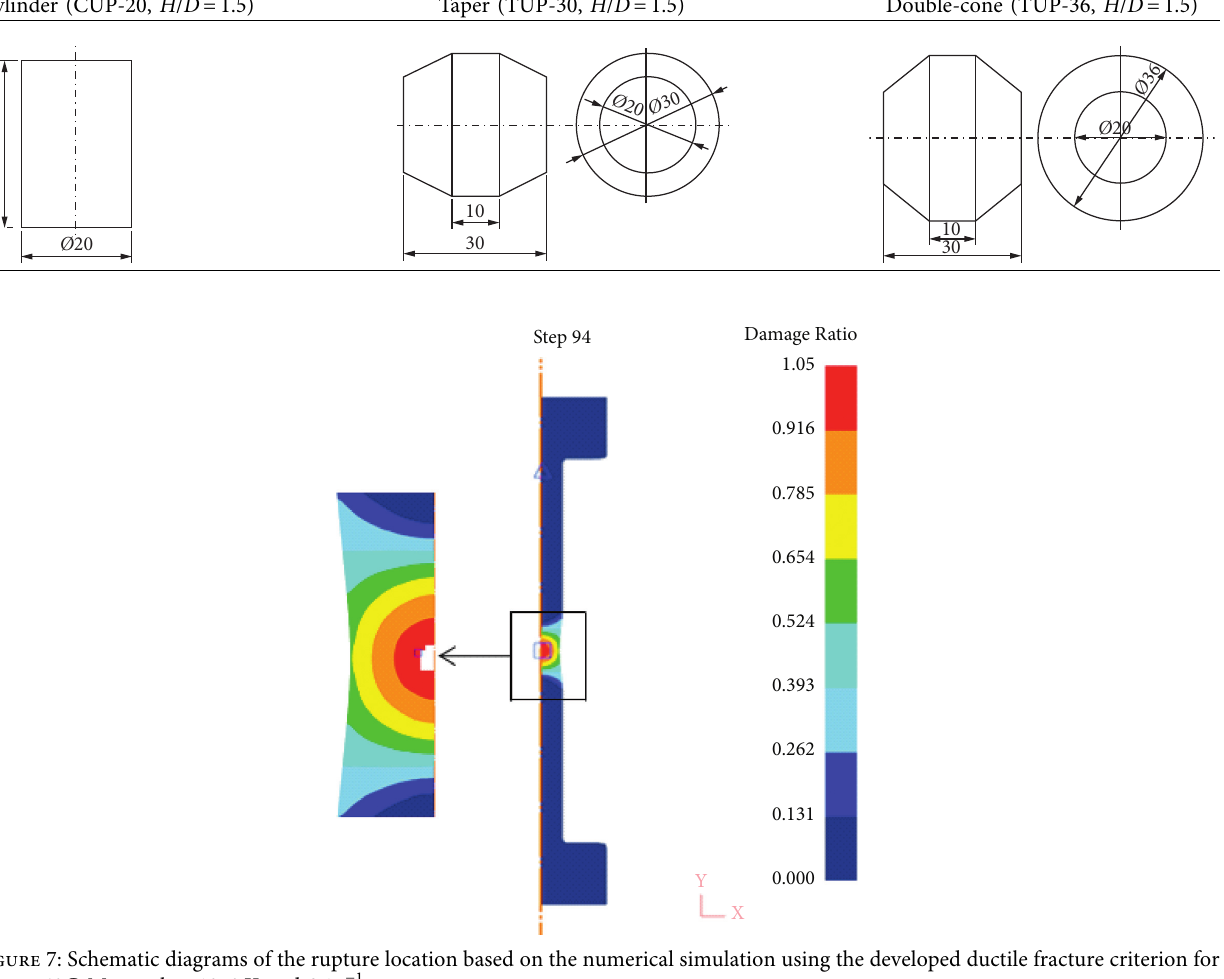
Table 2: As-cast 42CrMo steel specimens with different geometric shapes and sizes. Cylinder (CUP-20, H / D � 1.5)